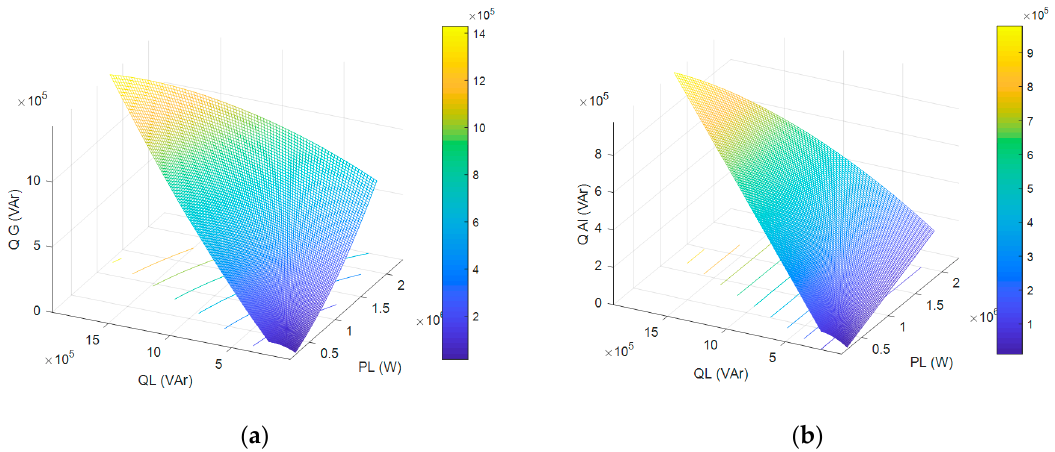
Figure 11. ( a ) Reactive power diagram in the EESG for k = 0.5. ( b ) Reactive power diagram in SGAR+AI for k = 0.5.